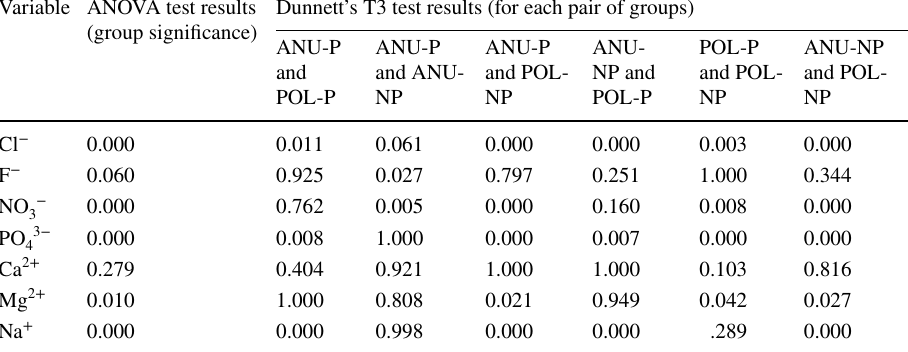
Table 4 ANOVA test with Dunnett’s T3 post hoc test results ( p values) for primary data